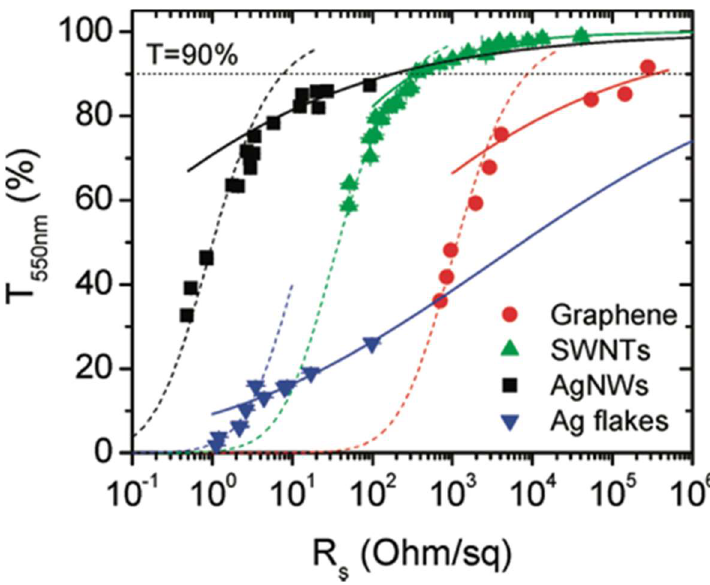
Figure 1. Transmittance (550 nm) plotted as a function of sheet resistance for thin films prepared from four nanostructured materials: graphene, single-walled carbon nanotubes, silver nanowires, and silver flakes. The dashed lines represent fits to the bulk regime using equation (5), while the solid lines represent fits to the percolative regime using equation (9). Reprinted from [12], with permission from American Chemical Society, 2010.